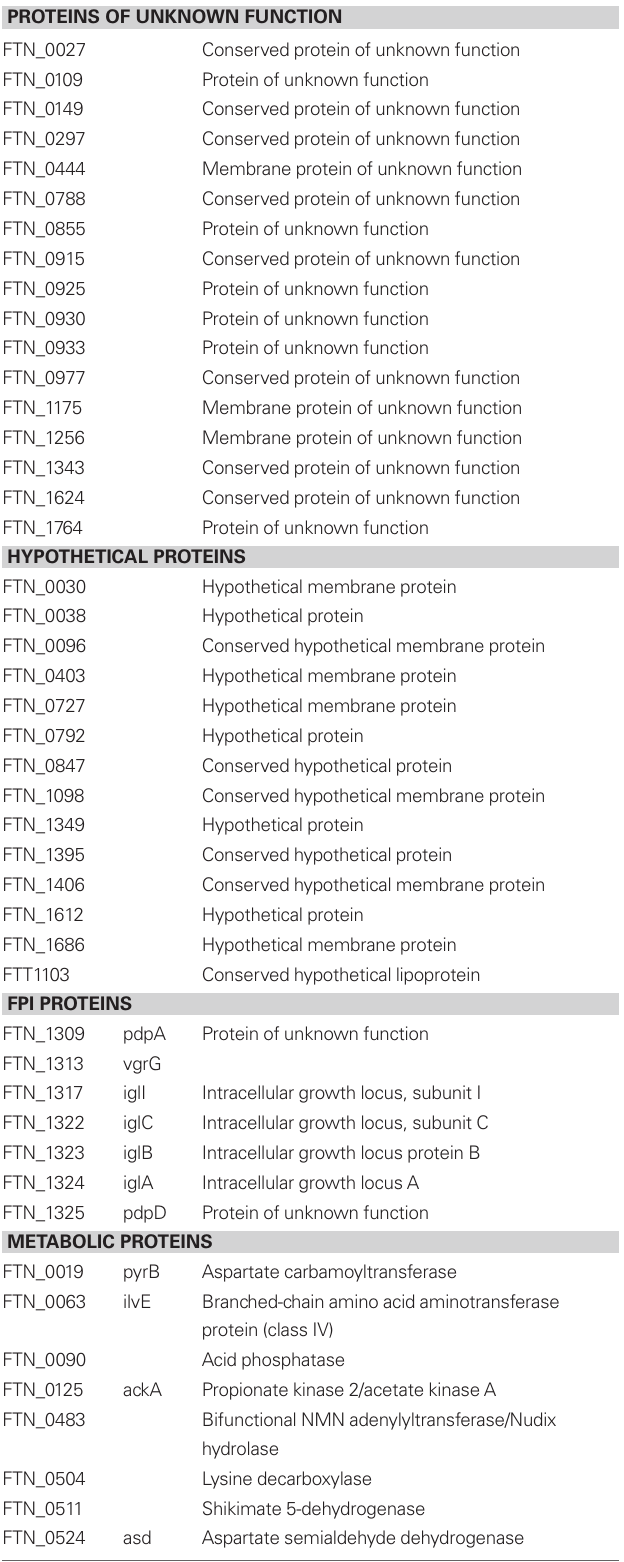
table 2 | list of escape defective